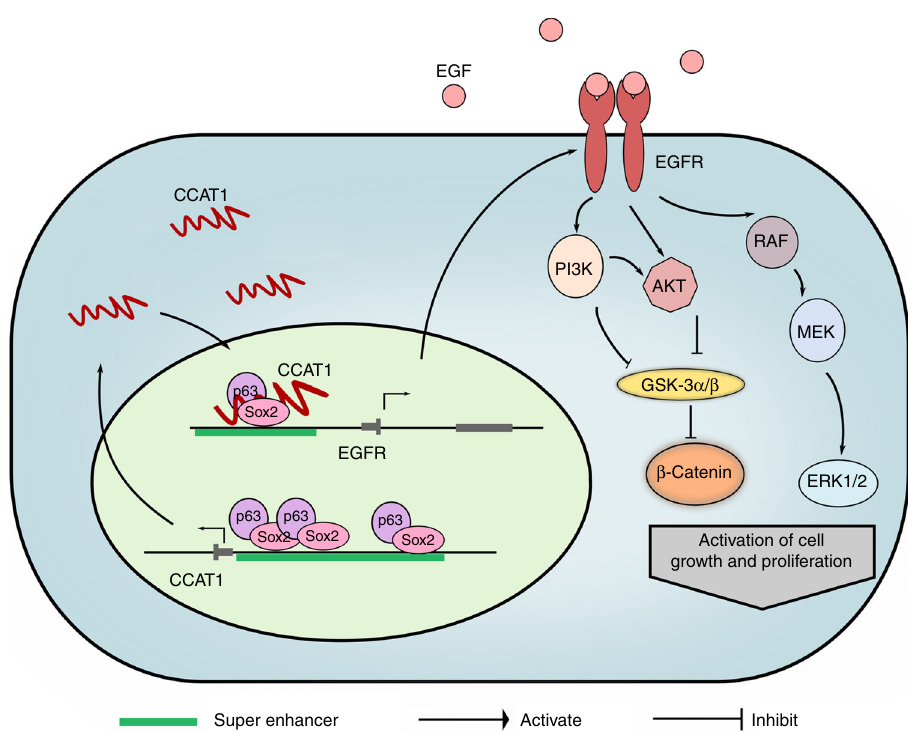
Fig. 7 Proposed model of transcriptional dysregulation in SCC biology. TP63 and SOX2 co-bind at CCAT1 promoter and super-enhancer regions, drive CCAT1 expression and form TP63/SOX2/CCAT1 complex, which occupies at super-enhancer domains of EGFR . This leads to the upregulation of EGFR expression, promoting SCC tumor development through activating MEK/ERK1/2 and PI3K/AKT signaling